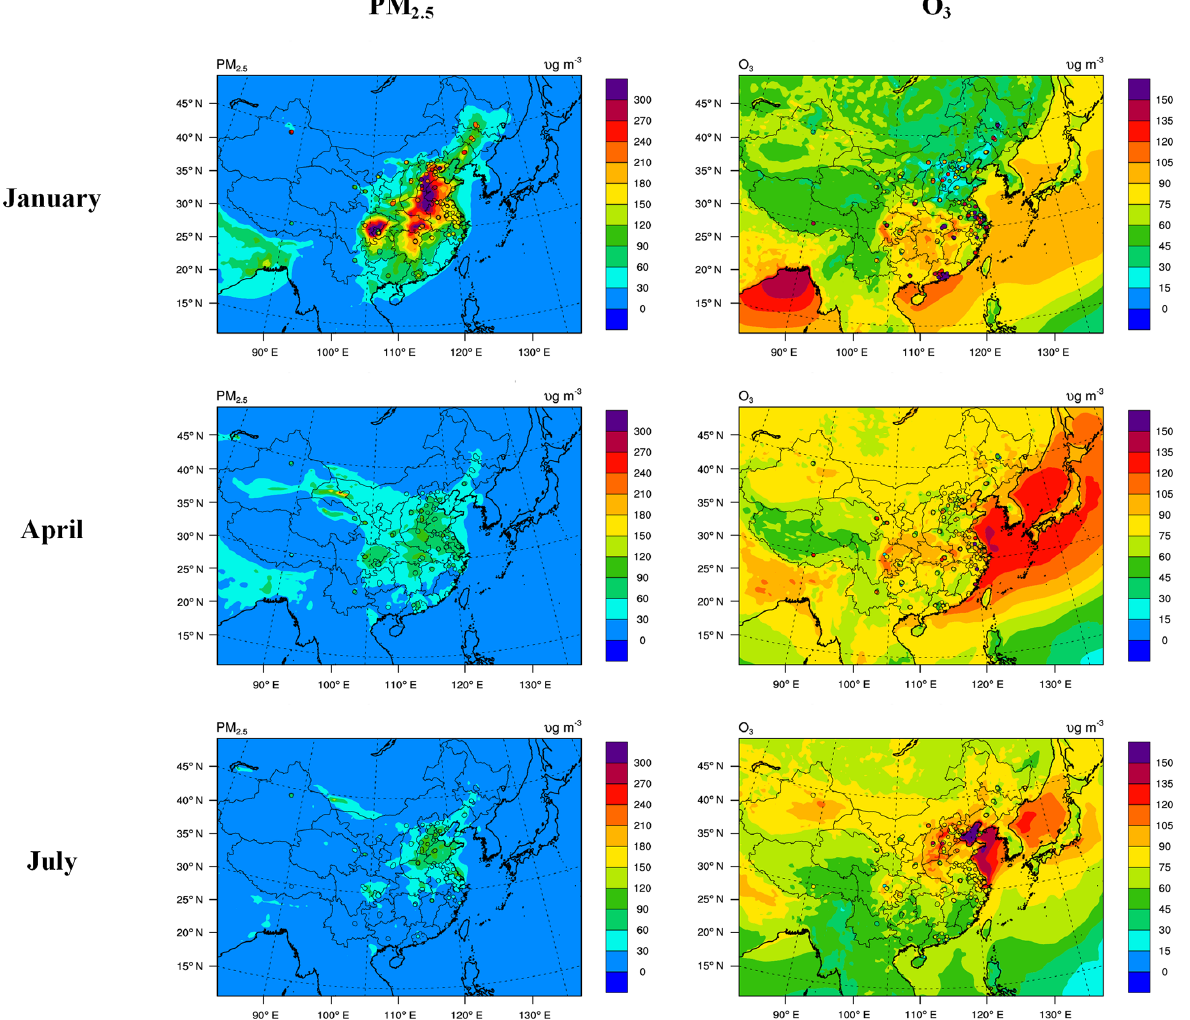
Figure 7. Spatial distribution of observed vs. simulated PM 2 . 5 and O 3 concentration during January, April, and July 2013, under the short- term air quality application. The background plots represent the simulated data, whereas observations are represented by the markers. Note that there were some errors in O 3 observational data in January